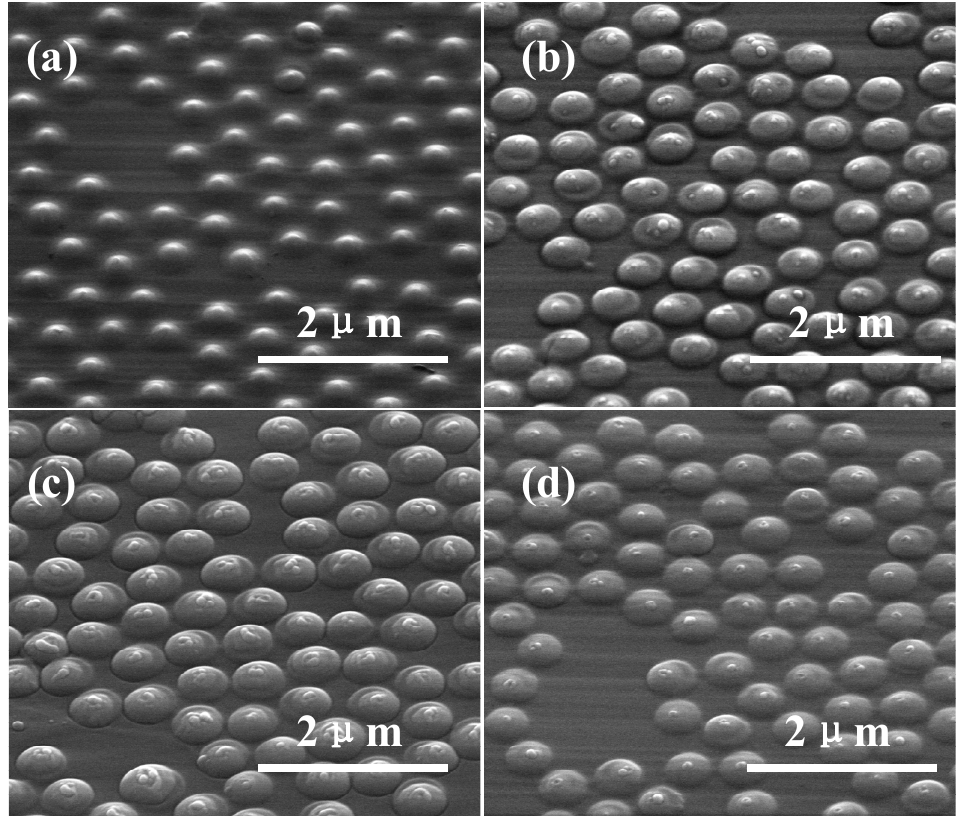
Figure 5. SEM images of submicron lenses on diamond surface acquired with 45° tilt angle of samples. ( a – d ) Submicron lenses fabricated by using CF 4 flow rate of 10, 15, 20 and 25 sccm, respectively.